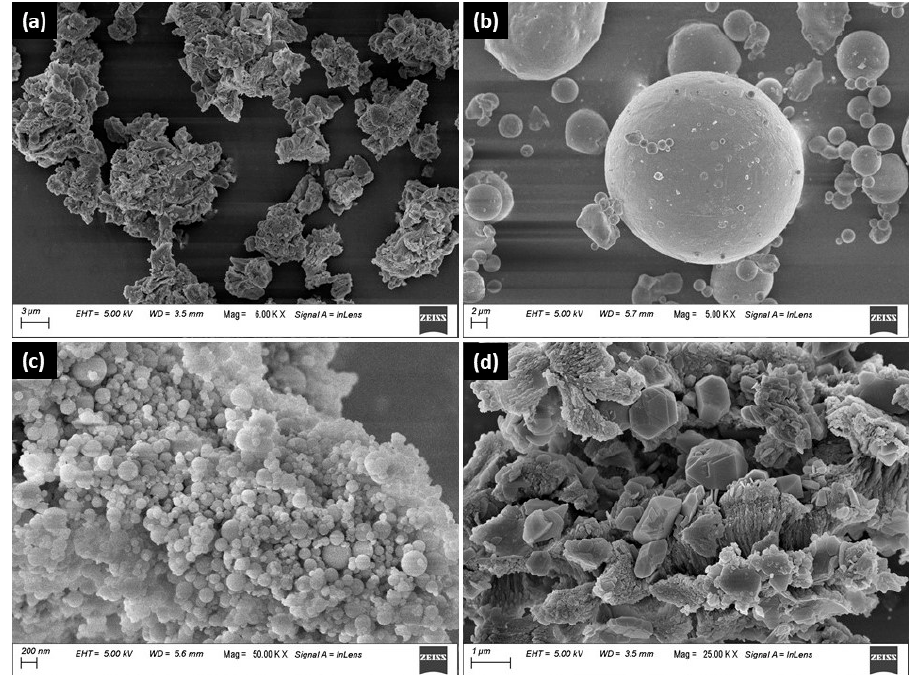
Figure 1. Morphology of ( a ) OPC, ( b ) FA, ( c ) SF, and ( d ) LP.